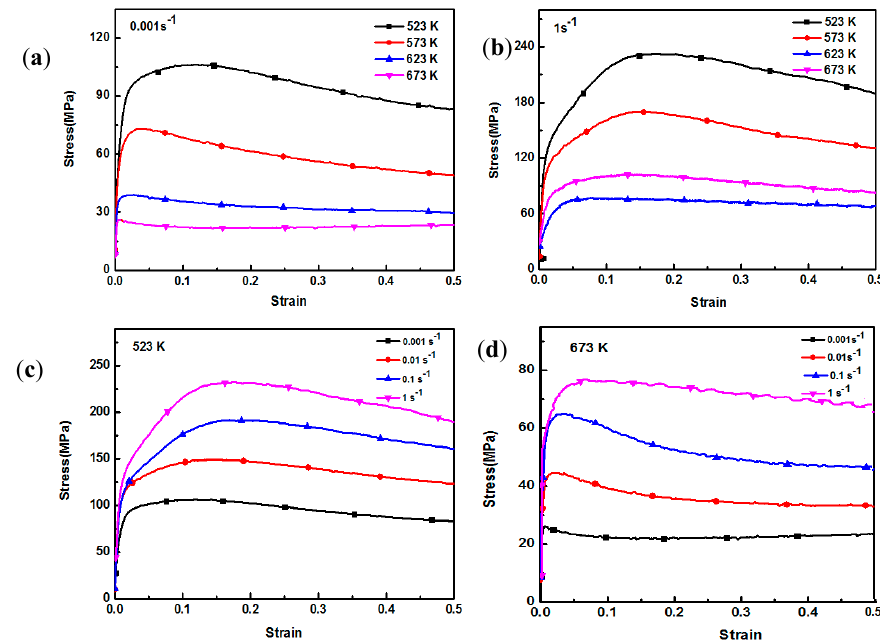
Figure 7. Compressive true stress-strain curves of nano-SiCp/AZ91 composite: ( a ) 0.001 s − 1 ; ( b ) 1 s − 1 ; ( c ) 523 K; ( d ) 673 K.